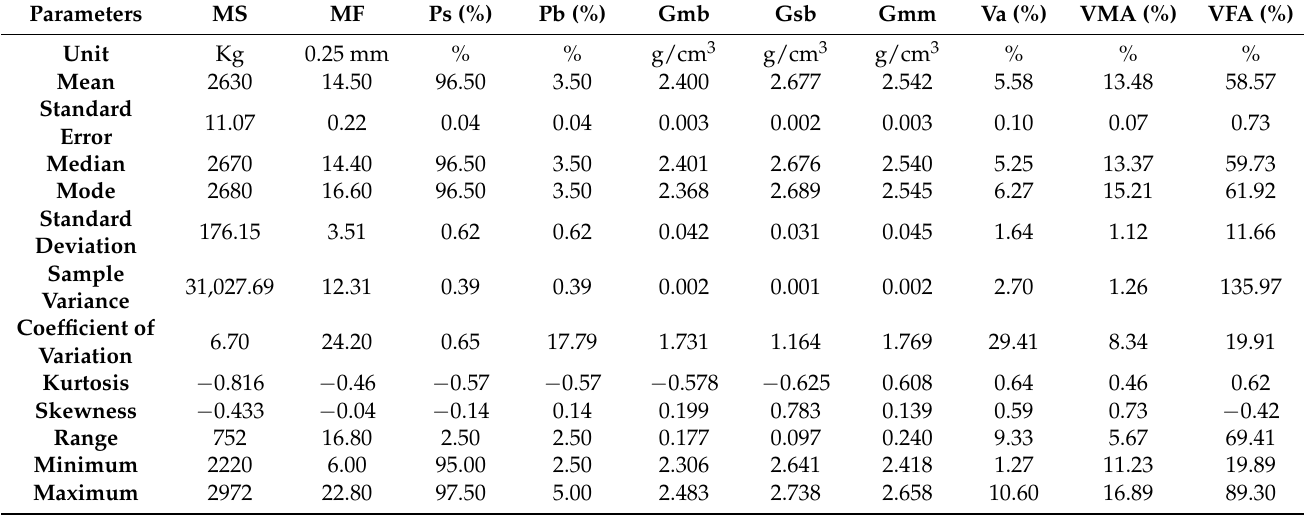
Table 3. Statistical range of input and output data of